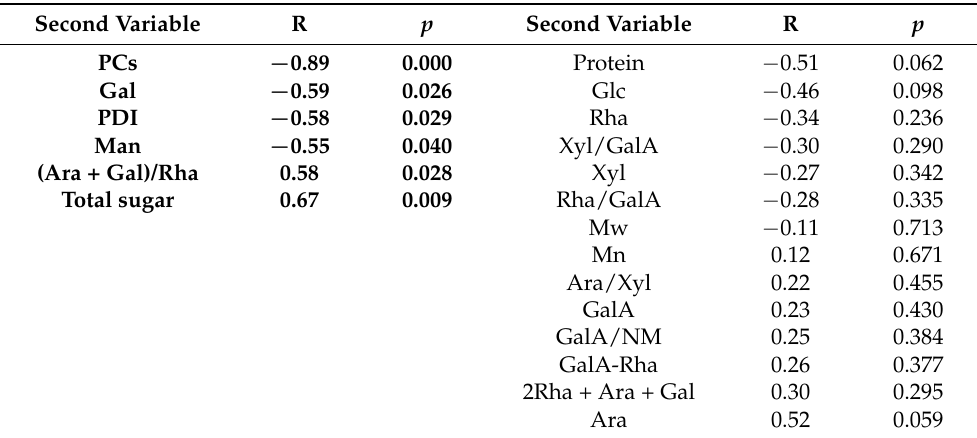
Table 4. The Pearson correlation coefficients between the DPPH scavenging activity and the chemical characteristics of polysaccharide fractions from S. passerine ( n = 14).